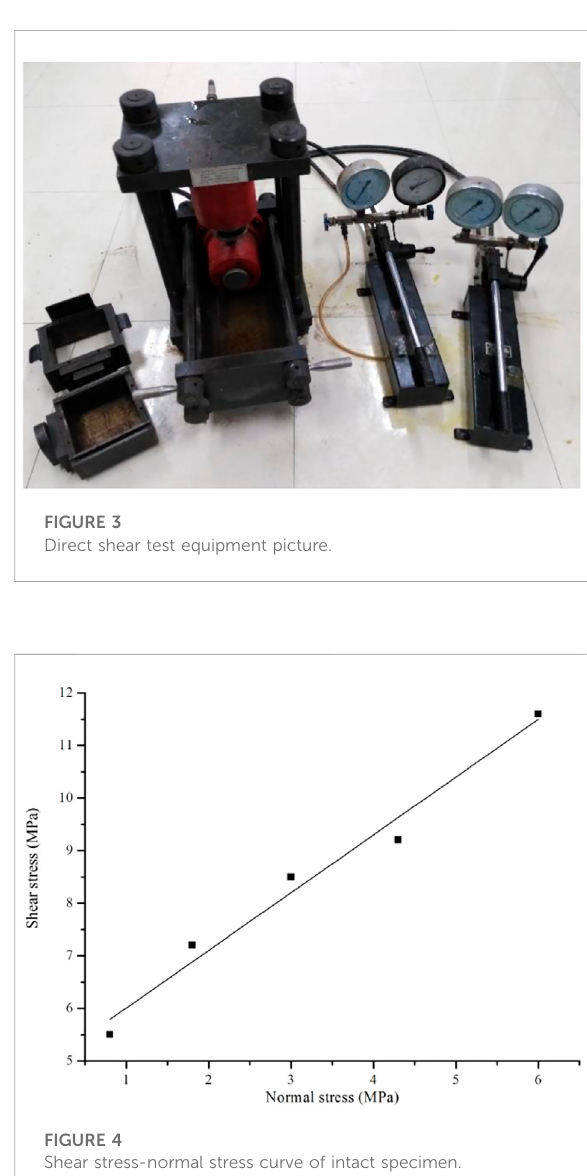
FIGURE 4 Shear stress-normal stress curve of intact